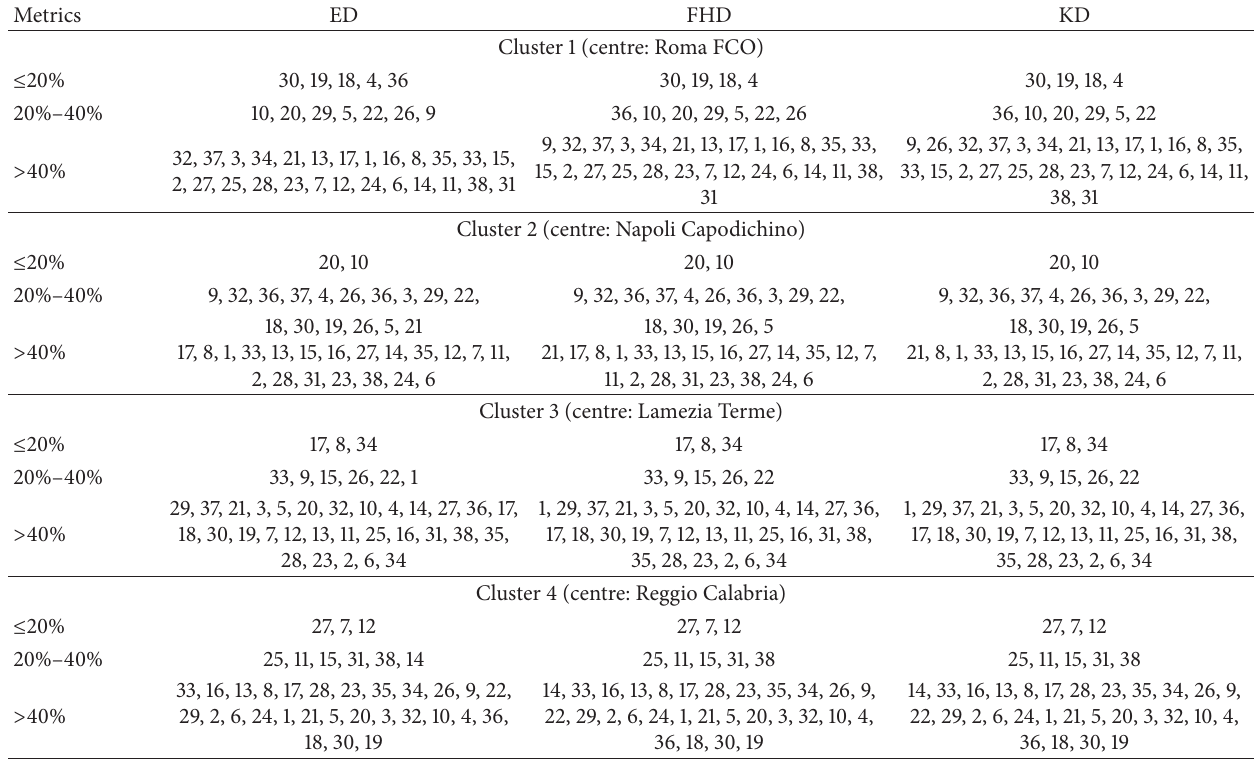
Table 3: Clustering results with prefixed number of clusters. Criterion: yearly passengers.